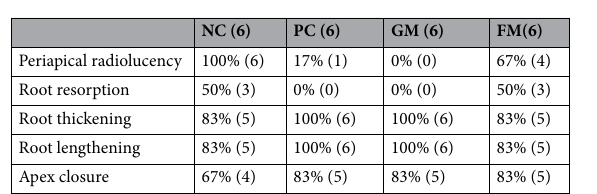
Figure 6. Representative radiographic and histologic images of the fibrin-based matrix scaffold (FM) group. Regenerative endodontic procedures were performed, involving FM application after bleeding induction, followed by MTA capping and glass ionomer restoration. Periapical radiographs were taken preoperatively and 4 and 12 weeks after treatment ( A , B , and C , respectively). Internal root resorption (arrowhead) and periapical radiolucency in both roots were observed (white line square, C ). After 12 weeks, the teeth were retrieved and processed for histologic analysis. Full images of the tooth (indicated in the left periapical radiograph) ( D ). Mesial root showing an irregularly obliterated root with newly deposited mineralized tissue without an odontoblastic layer ( E ), while the distal root showed a resorptive lesion with inflammatory cell infiltration ( F ).